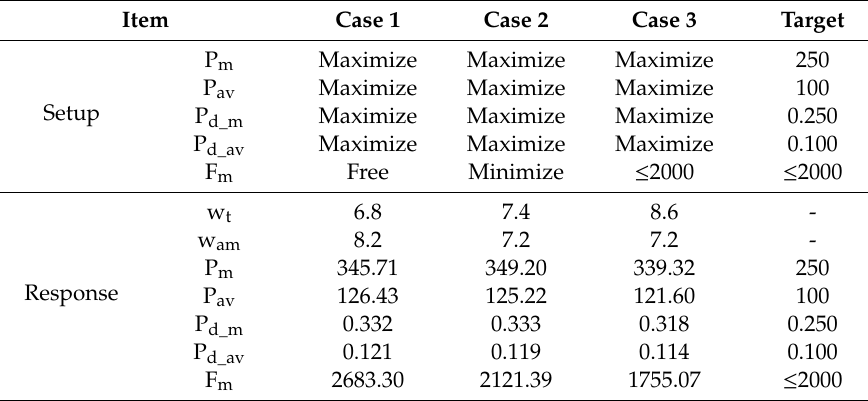
Table 4. Factors and machine’s performance.